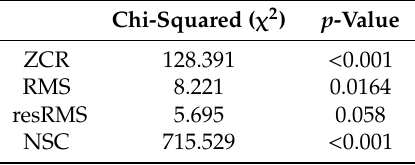
Table 3. Results from the non-parametric Friedman test of di ff erences across repeated measures of the three intra-oral appliances conditions per descriptor. Register data is merged per appliance condition. Chi-square ( χ 2 ) and the statistical significance ( p -value) are